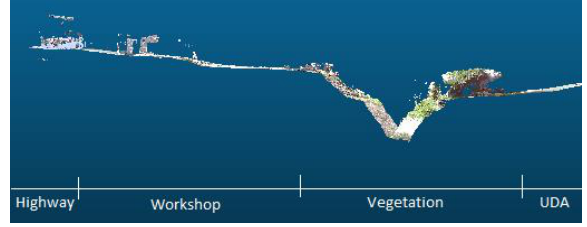
Figure 12. Down profile distribution.